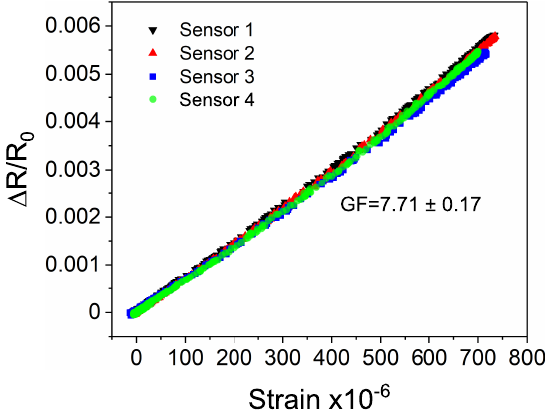
Figure 7. Comparative analysis and calibration of four of the same strain sensors with the hybrid construction. The demonstrated results show good repeatability between the sensors.